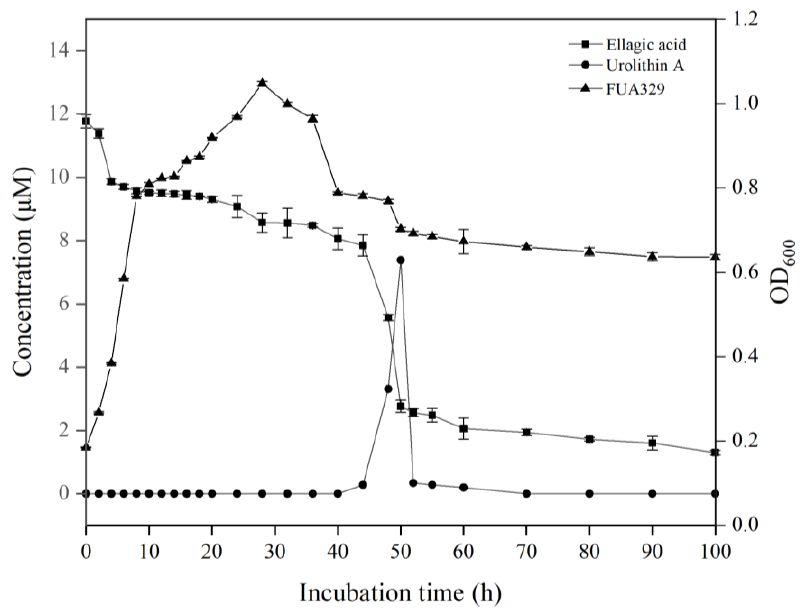
Figure 3. Phylogenetic tree of the strain FUA329 within the genus Streptococcus based on 16S rRNA sequences. The branching pattern was generated by using the maximum-likelihood method. Boot- strap values over 50% from 1000 replications are shown on the branches. The bar below the tree represents 1 nucleotide change per 1000 nucleotides.